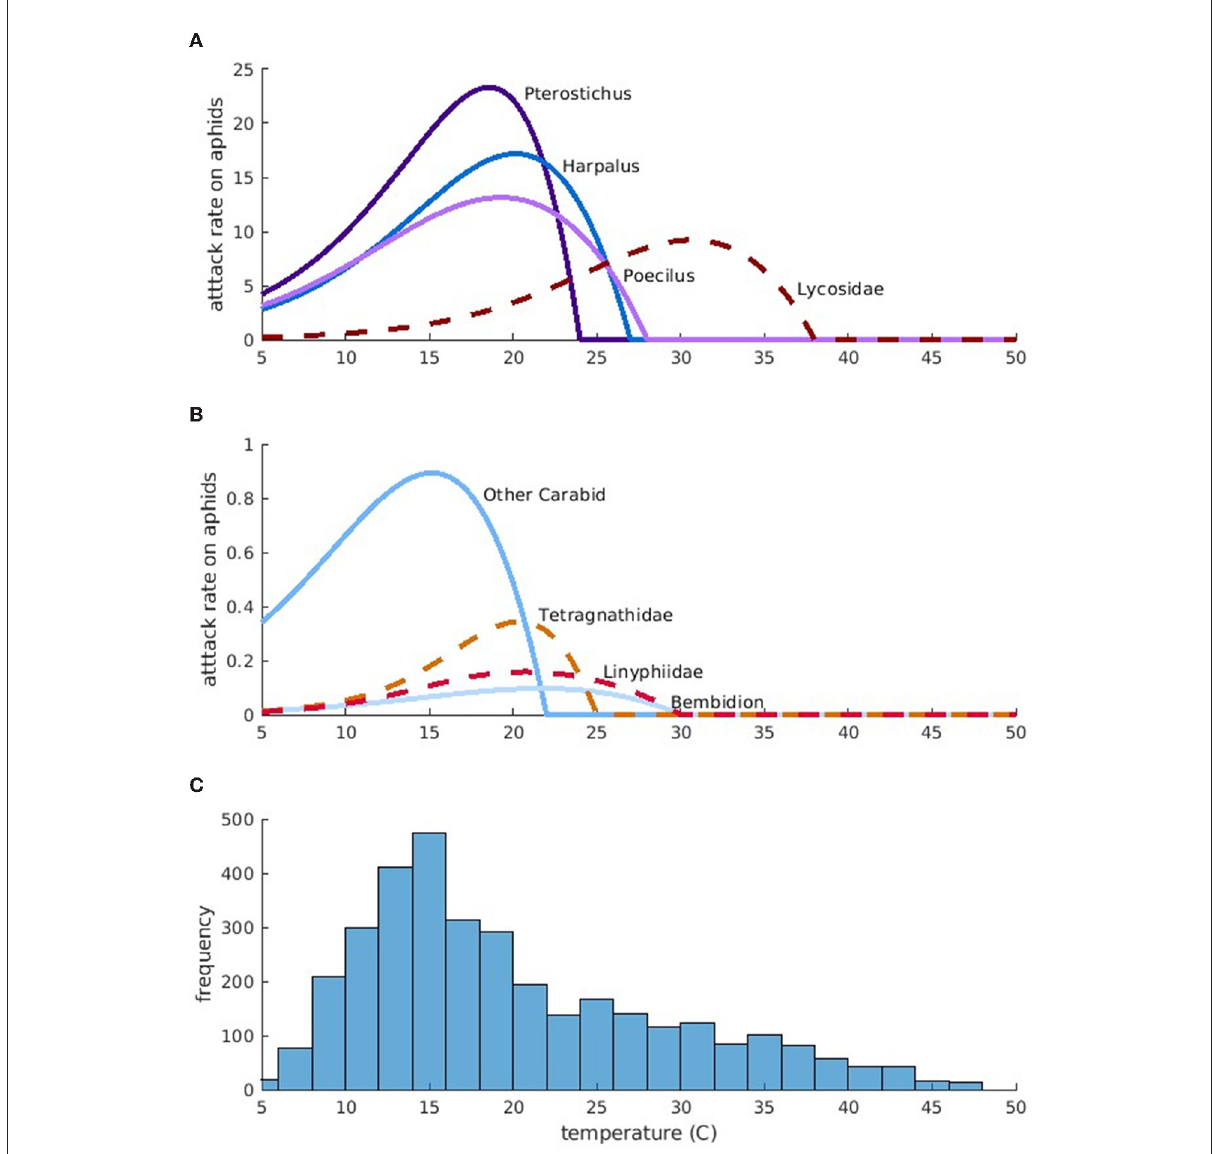
FIGURE1 Simulated maximum potential aphid attack rates for each predator, per-capita as a function of temperature. Attack rates for larger predators are in (A) and attack rates for smaller predators are in (B) . Blue-toned, solid lines indicate groundbeetles and red-toned, dashed lines indicate spiders. Darker colors indicate larger predators within either category. (C) Is a histogram of temperature observations across all field